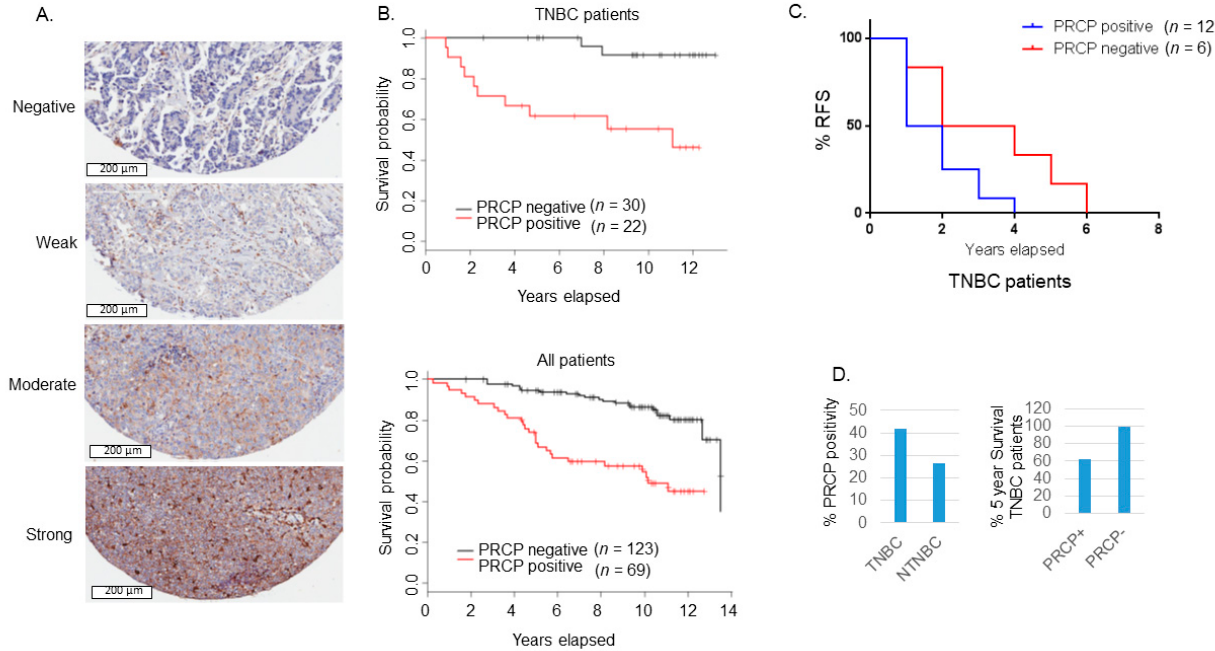
Figure 1. PRCP-positive BC patients have poor outcomes. ( A ) Slides containing cores of breast cancer tissues were deparaffinized and stained with primary PRCP antibody (# HPA017065, Human Protein Atlas). PRCP displayed a granular cytoplasmic pattern. TMA staining was scored based on intensity (negative, weak, moderate, and strong) and percent cell staining. The criteria for PRCP positivity are that more than 60% of the cells have moderate to strong staining. Scale bar: 200µm. ( B ) Primary breast cancer tissues from 192 patients treated at Rush Medical Center from 2000–2005 were stained for PRCP. Kaplan-Meier curves show overall survival (OS) is significantly lower in PRCP-positive TNBC patients ( p = 0.0004) (top) and in PRCP-positive breast cancer patients (all patients, bottom) ( p < 0.0001). ( C ) Primary breast cancer tissues of 18 recurrent TNBC patients treated at UIC from 1994–2004 were stained for PRCP. Kaplan-Meier recurrent free survival (RFS) shows RFS is significantly shorter in PRCP-positive TNBC patients ( p = 0.041). ( D ) TNBC tumors have higher percentage (41.8%) of PRCP-positivity than non-TNBC (NTNBC, 26.6%). The 5-year survival rate is 61.9% in PRCP-positive TNBC patients, and 100% in PRCP-negative TNBC patients.